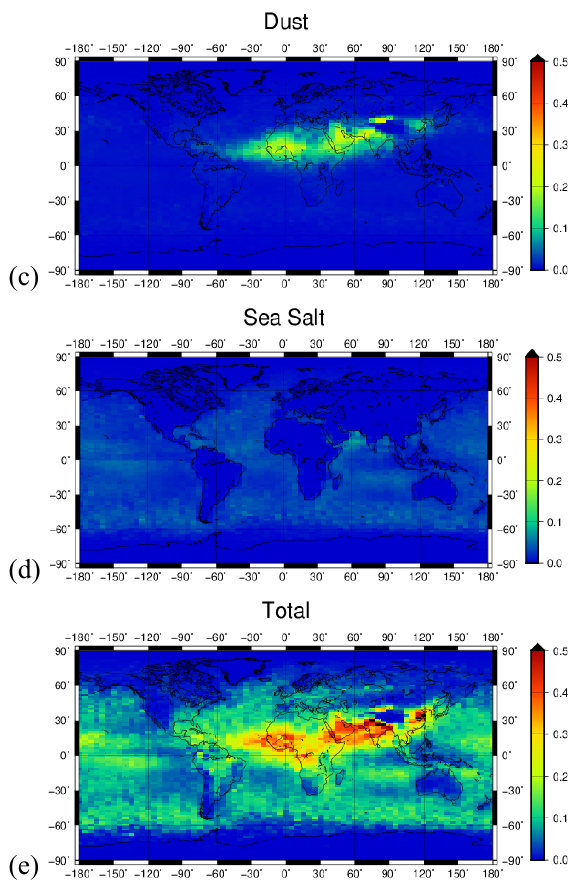
Figure 1. The annual mean clear-sky aerosol optical thickness (AOT) in 2010 during day-time from this study where the resolution of latitude 2º - longitude 5º. (a) Water Soluble, (b)LAC (Black Carbon), (c)Dust, (d)Sea Salt,